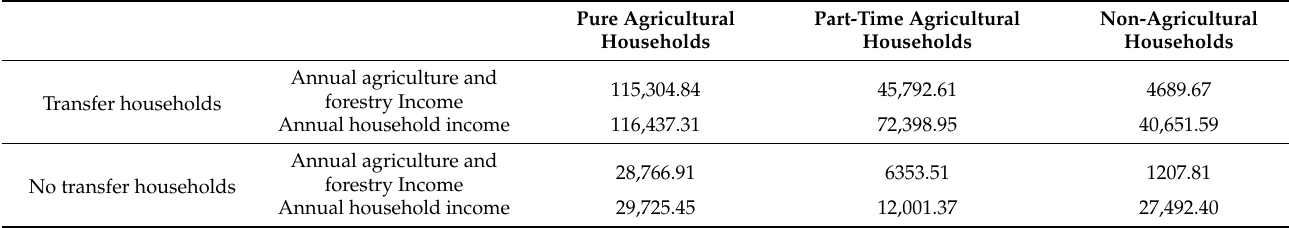
Table 10. Income of different types of agricultural households.